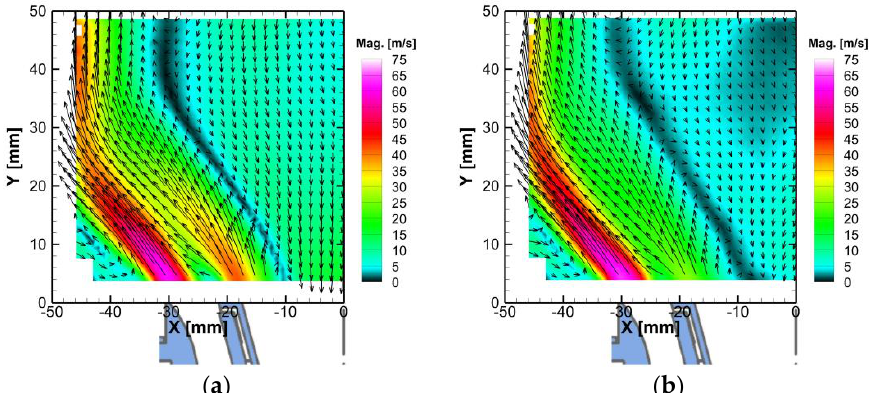
Figure 14. OH-LIF distribution under idle conditions: ( a ) case P and ( b ) case M. (Illustration of the burner exit section is superimposed beneath the horizontal axis).